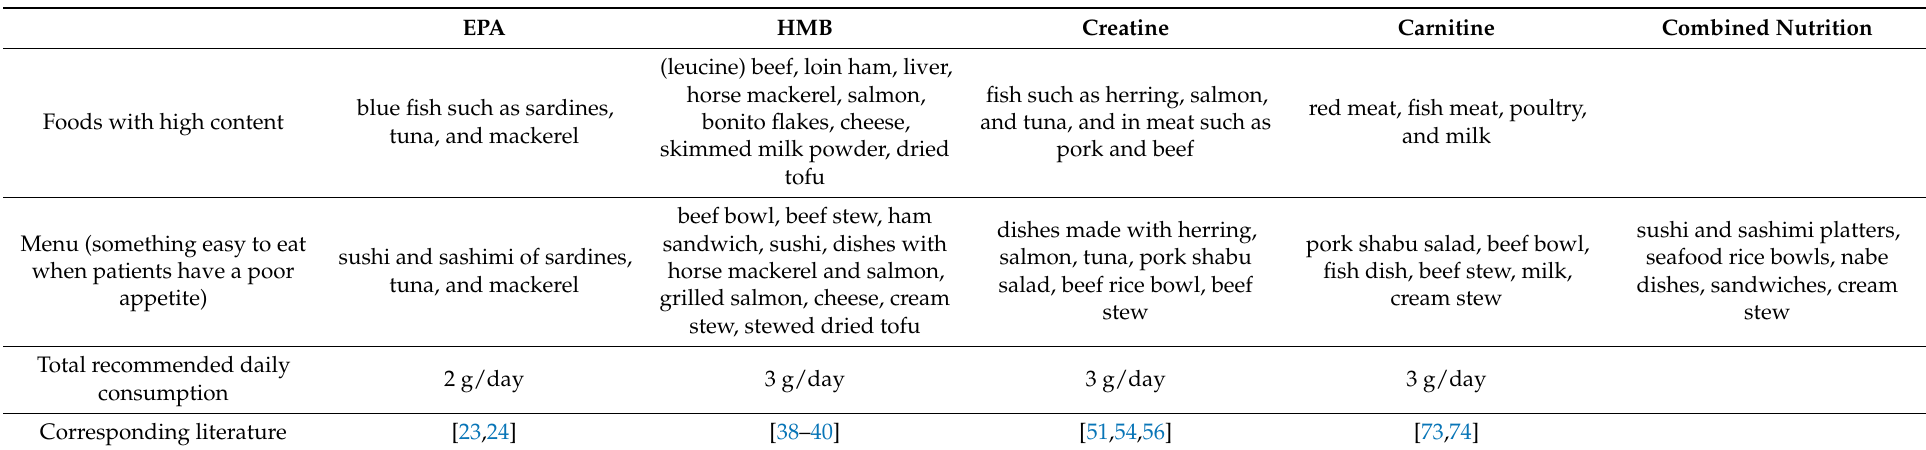
Table 2. List of proposed